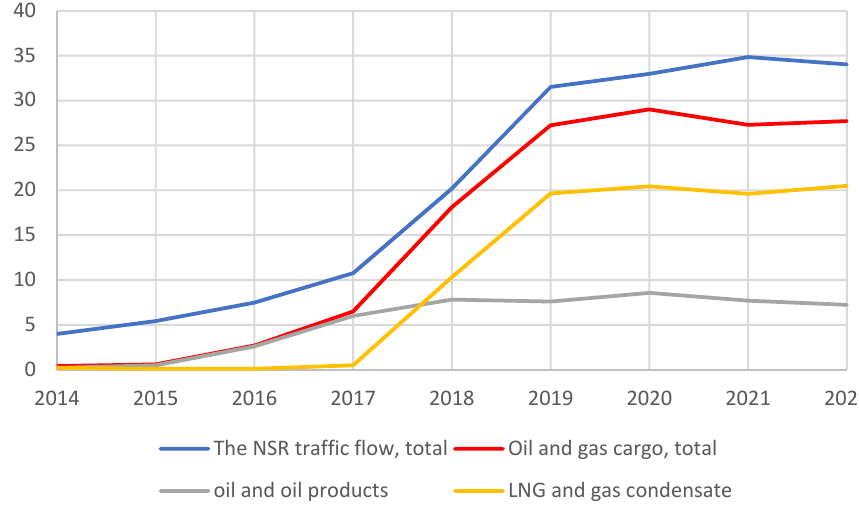
Figure 6. The NSR traffic flow in 2014–2022 by type of cargo, mln t. Source: compiled by the author according to the data of [6,38,44,57,58].